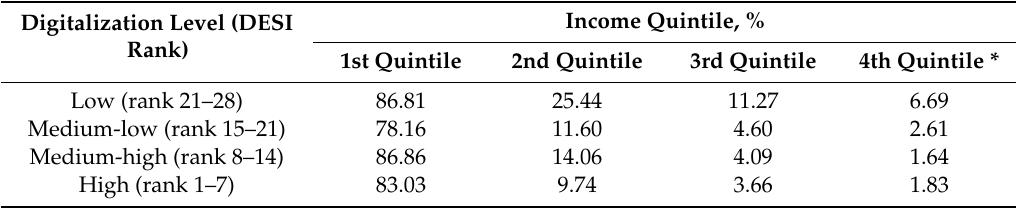
Table 7. Average AROPE by income and level of digitalization in the EU countries in 2018,